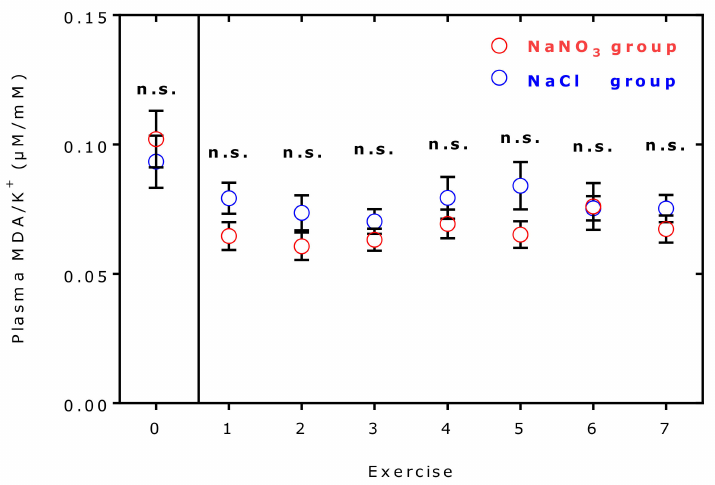
Figure 7. Molar ratio of plasma malondialdehyde (MDA) to plasma potassium (K + ) in the volunteer- ing persons of the NaNO 3 and NaCl groups at baseline and at the seven exercise timepoints after supplementation of NaCl or NaNO 3 (see Scheme 2). Data are shown as the mean with standard error of the mean. n.s., not significant (unpaired t test with Welch’s